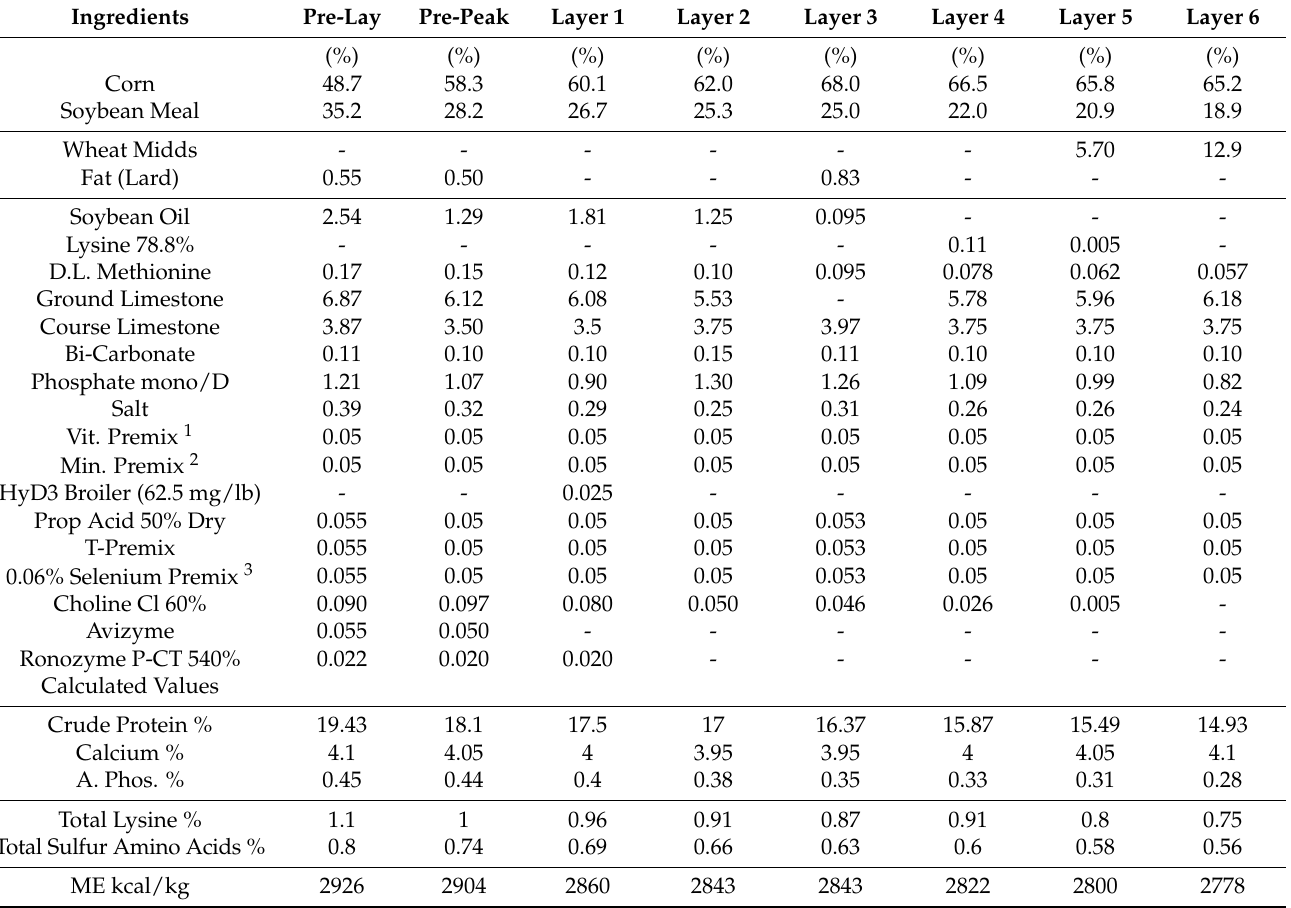
Table 3. Ingredient composition and calculated nutrient analysis of diets fed to all hens according to the feeding program described in Table